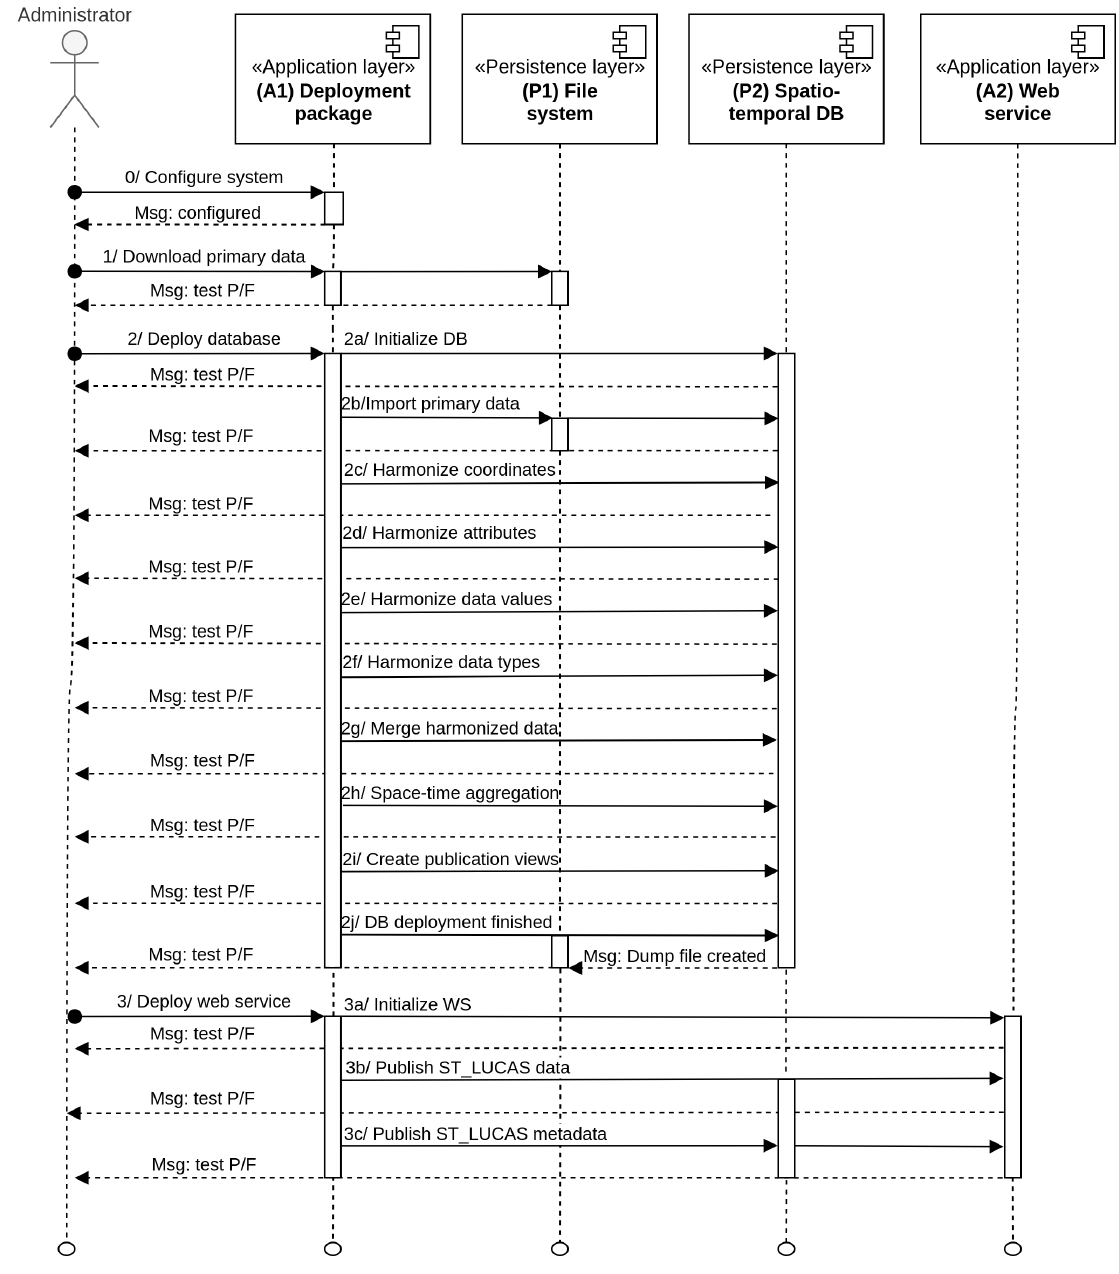
Figure 5. ST_LUCAS dynamic architecture (system